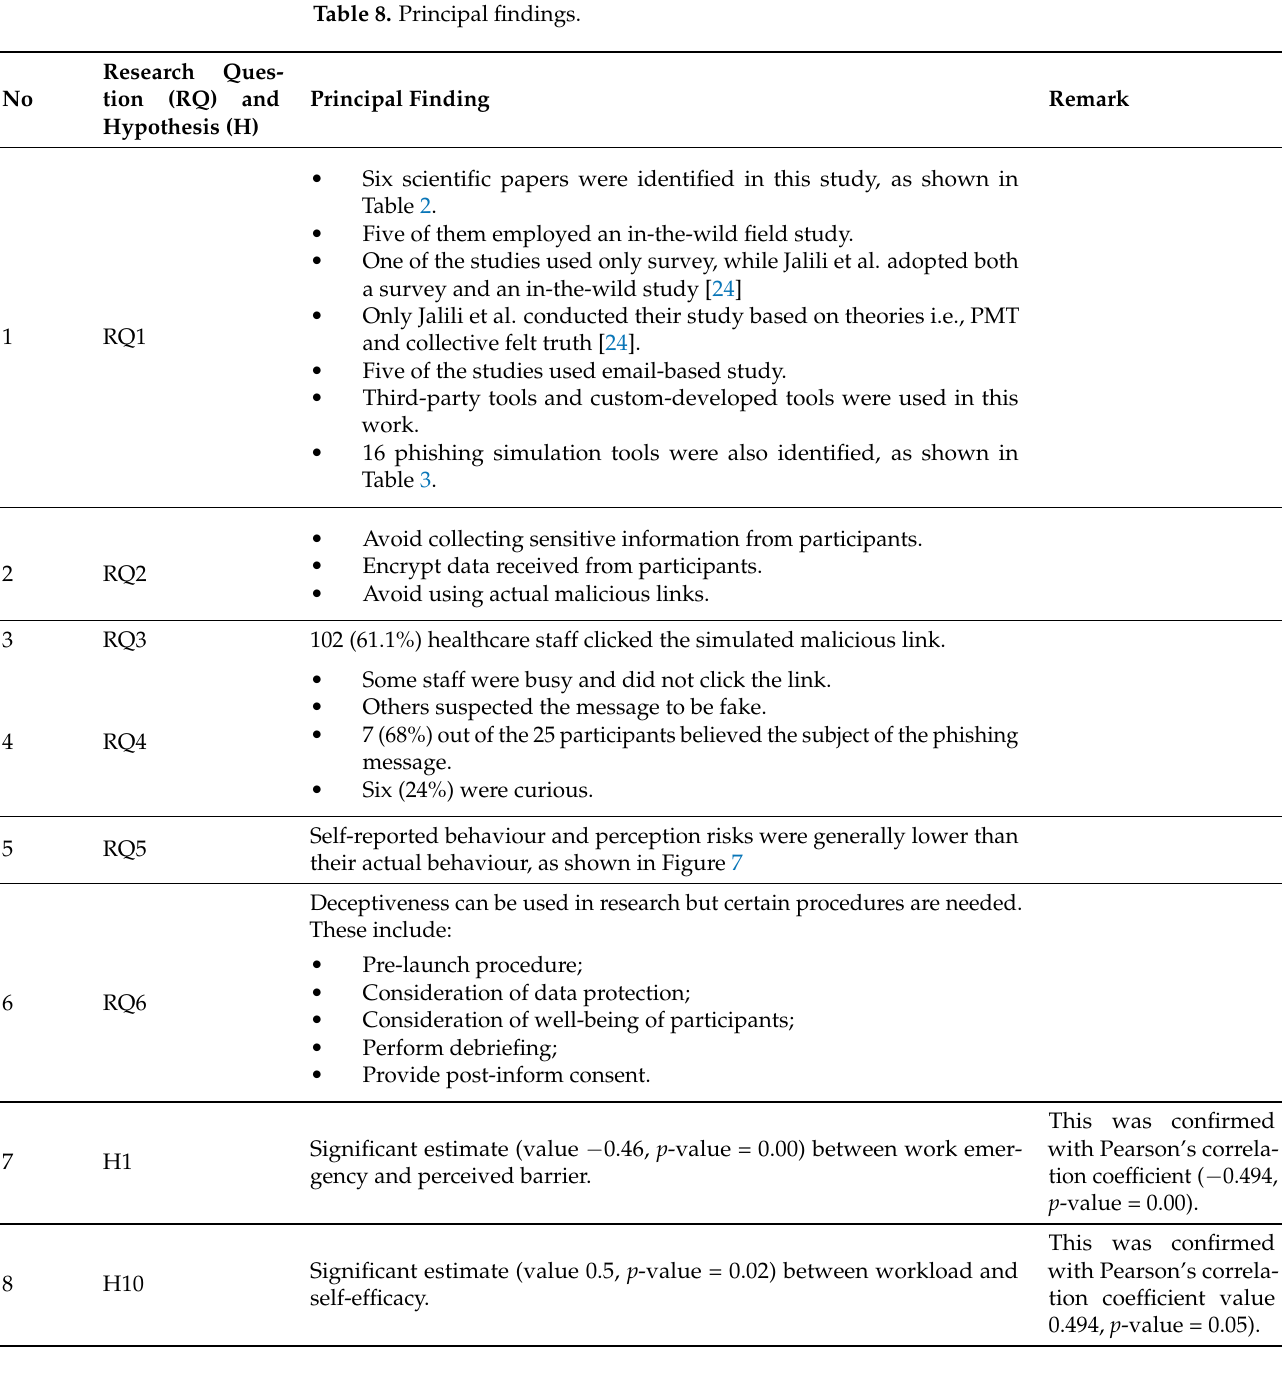
Table 8. Principal